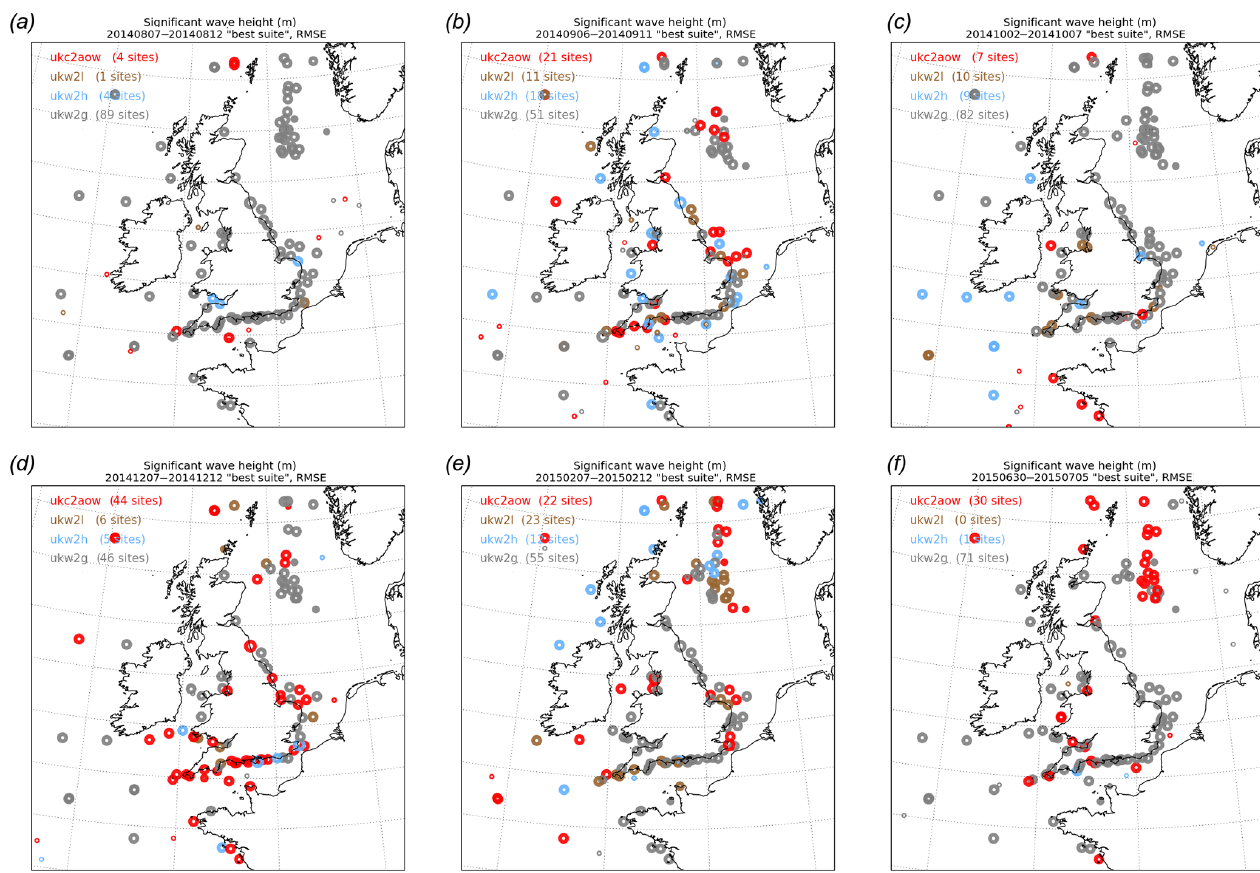
Figure 12. Distribution of in situ observation sites for which each of UKC2aow, UKW2l, UKW2h or UKW2g wave model significant wave height outputs provided the lowest RMSE statistic for each 5-day case study. Note that only an inner section of the domain is presented for